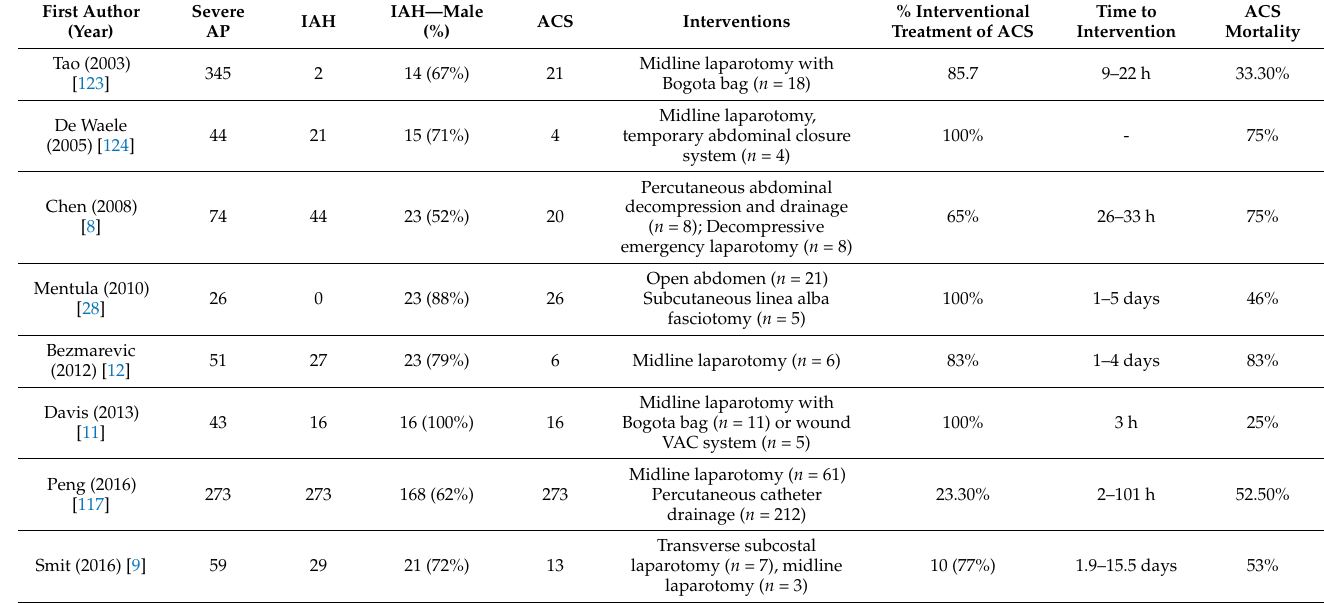
Table 1. Abdominal compartment syndrome in the context of severe acute pancreatitis—prognosis and surgical